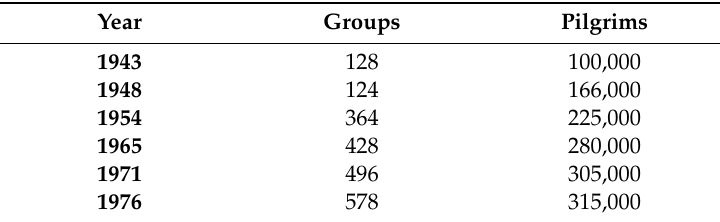
Table 2. Organised pilgrims reaching the city of Santiago in the Holy Years. Source: Data reported by Rodr í guez (2004) based on the analysis of the O ffi cial Journal of the Archdiocese, press, and other publications. Year Groups